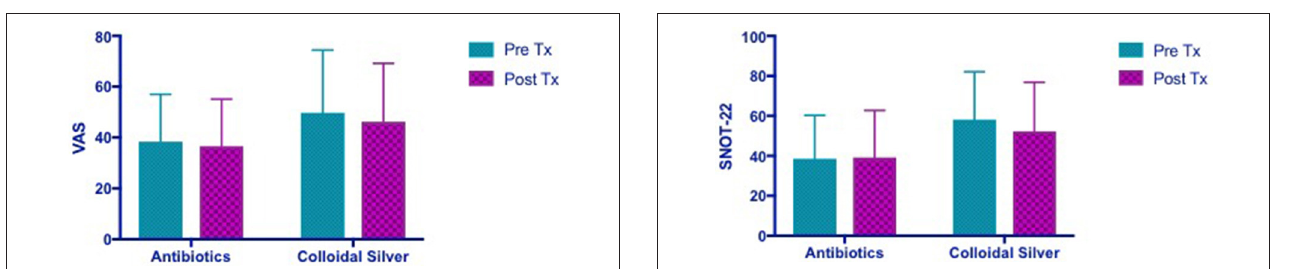
Subgroup Analyses: Crossover Silver Arm Five patients completed the crossover CS arm after failing oral antibiotics. Subgroup analyses were performed comparing VAS, SNOT-22, and LKS scores of patients while on either treatment. The mean score difference post antibiotic treatment vs. post CS treatment were compared using Wilcoxon matched-pairs signed rank tests. However, due to the small sample size of our subgroup analyses, data presented is focused on describing observed